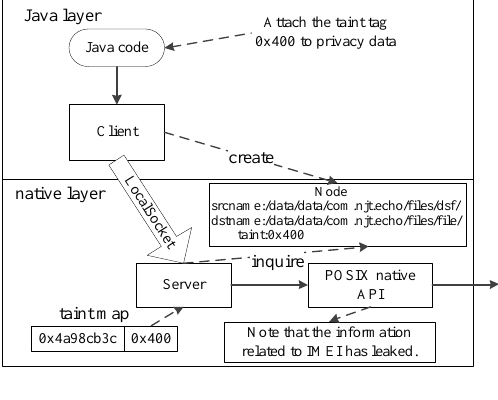
Figure 14. Echo.apk. Figure 14.